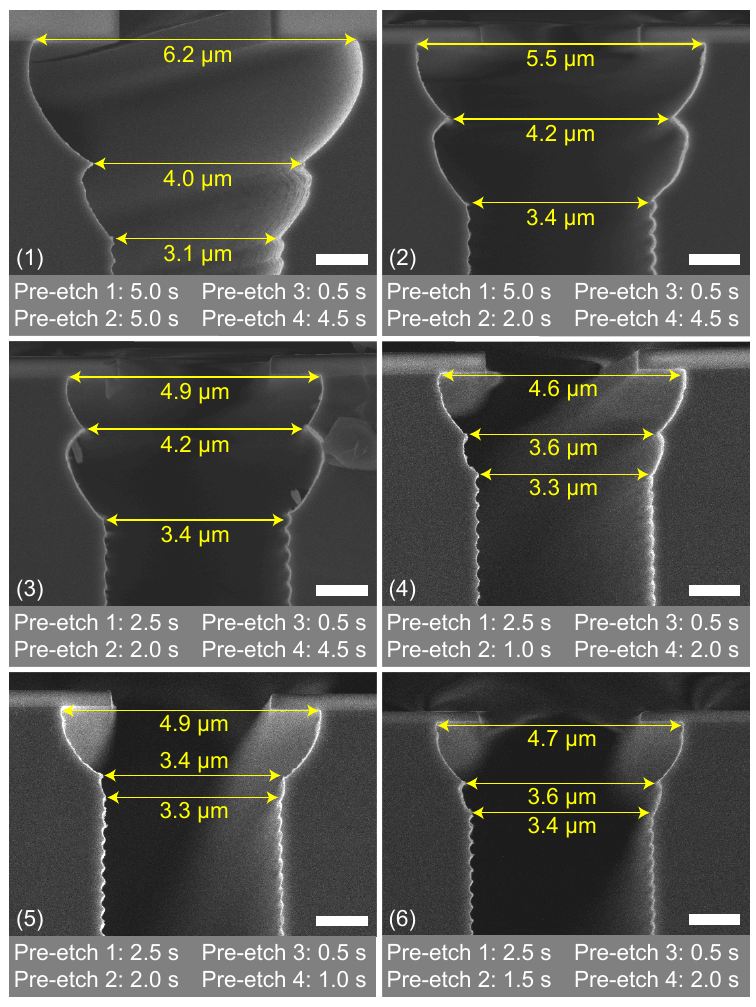
Figure 12. Optimisation of the trench entrance etch sequence. The deposition step between etch 2 and etch 3 was kept constant (2.4s). The numbers correspond to the experiment numbers in Table 2. All scale bars are